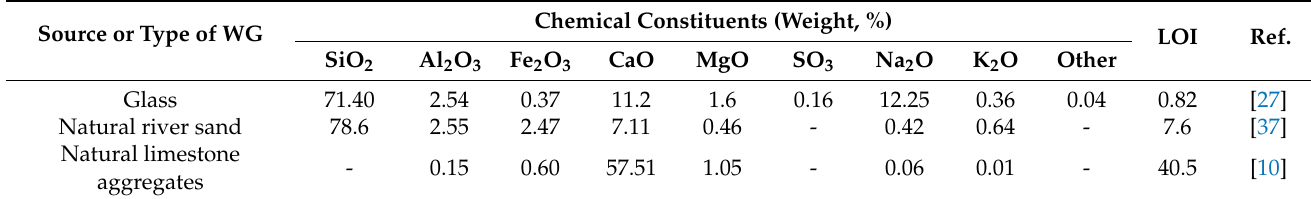
Table 3. Chemical composition of natural river